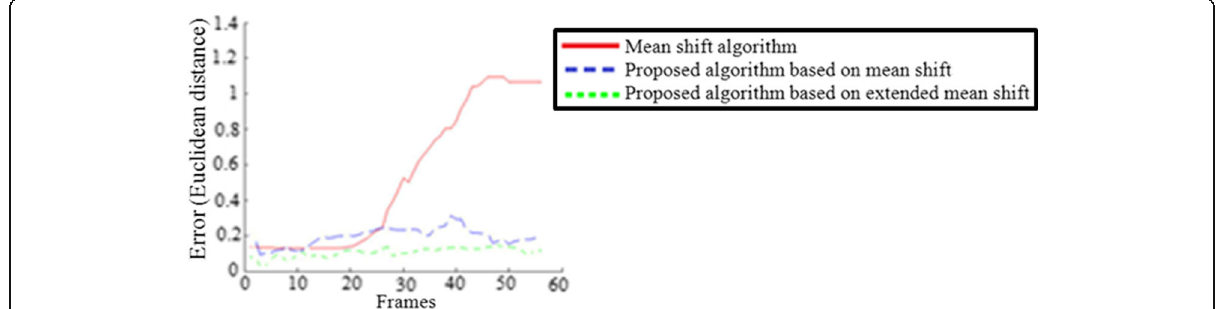
Fig. 26 Comparison of different algorithms in object tracking under low contrast condition based on tracking error